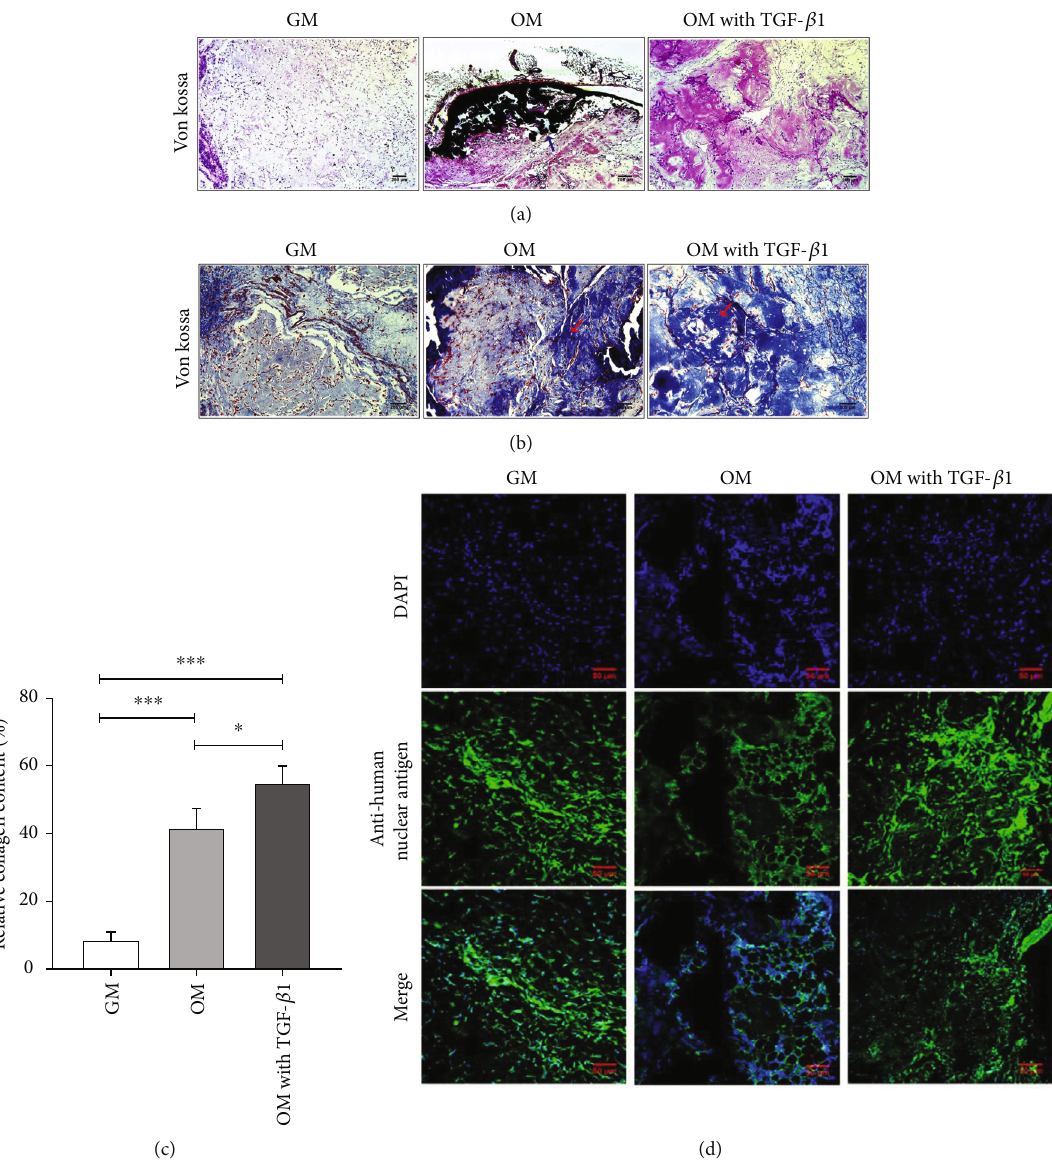
Figure 5: E ff ect of TGF- β 1 on odontogenic di ff erentiation of DPSCs in vivo . (a) Von Kossa staining in GM, OM, and TGF- β 1 groups (blue arrow indicates hard tissue formation) (50 × ). (b) Collagen is dark blue following Masson trichrome staining (red arrows) (100 × ). (c) Measurement of the area of collagen formation. Errorbars = means ± standard deviation (SD), n = 3 , statistically signi fi cant di ff erence at the levels ∗ p < 0 : 05 and ∗∗∗ p < 0 : 001 (ANOVA). (d) Indirect immuno fl uorescence for human nuclear antigen (green fl uorescence). GM: growth medium; DPSCs: dental pulp stem cells; OM: odonto-/osteo-genic medium; TGF- β 1: transforming growth factor- β